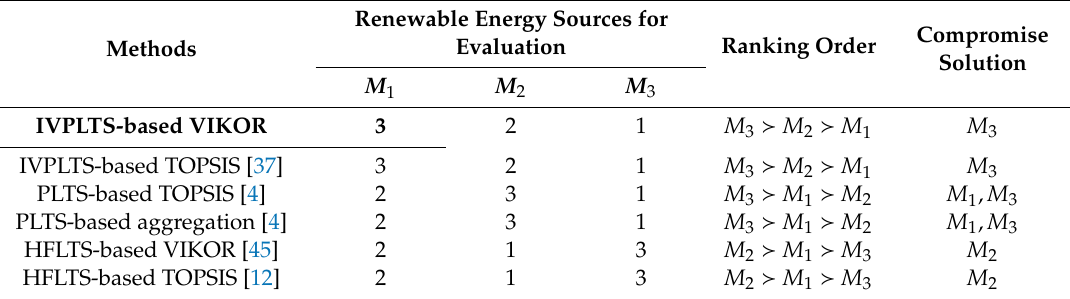
Table 6. Investigation of a ranking order by di ff erent ranking methods. Renewable Energy Sources Methods